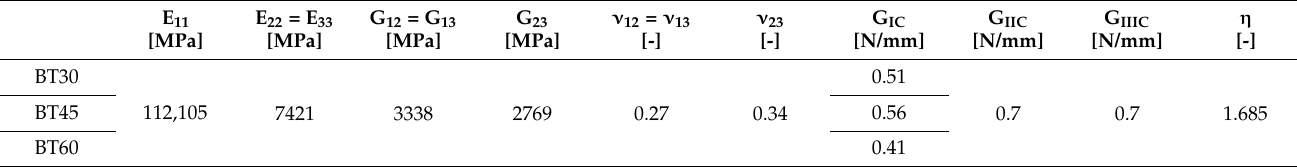
Table 3. Fracture and material parameters implemented during FE